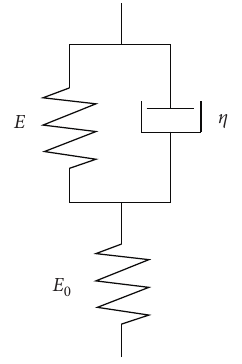
Figure 13: Three-parameter solid model.